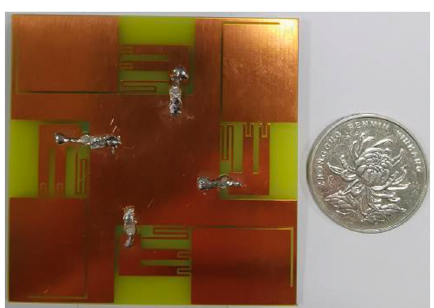
Figure 4: Photograph of the fabricated MIMO antenna.